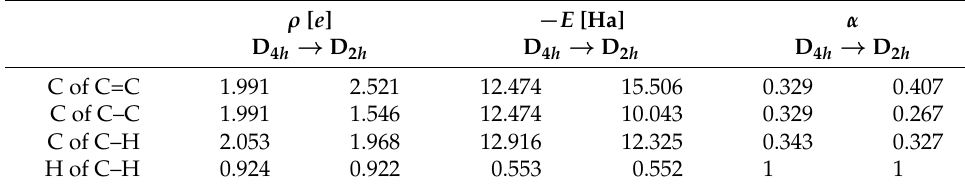
Table 1. Bond-wedge properties.